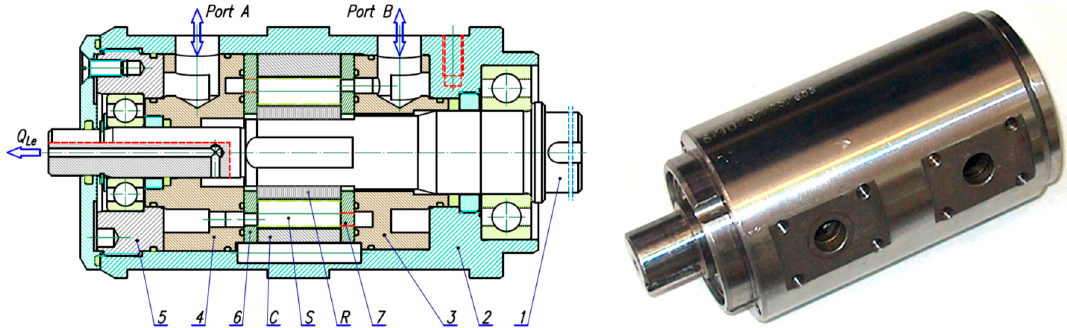
Figure 6. Hydraulic satellite motor [16]: C —curvature (stator); S —satellite; R —rotor; 1—shaft; 2—case; 3 and 4—inflow and outflow manifolds, respectively; 5—rear body; 6 and 7—distribution (compensation) plates.